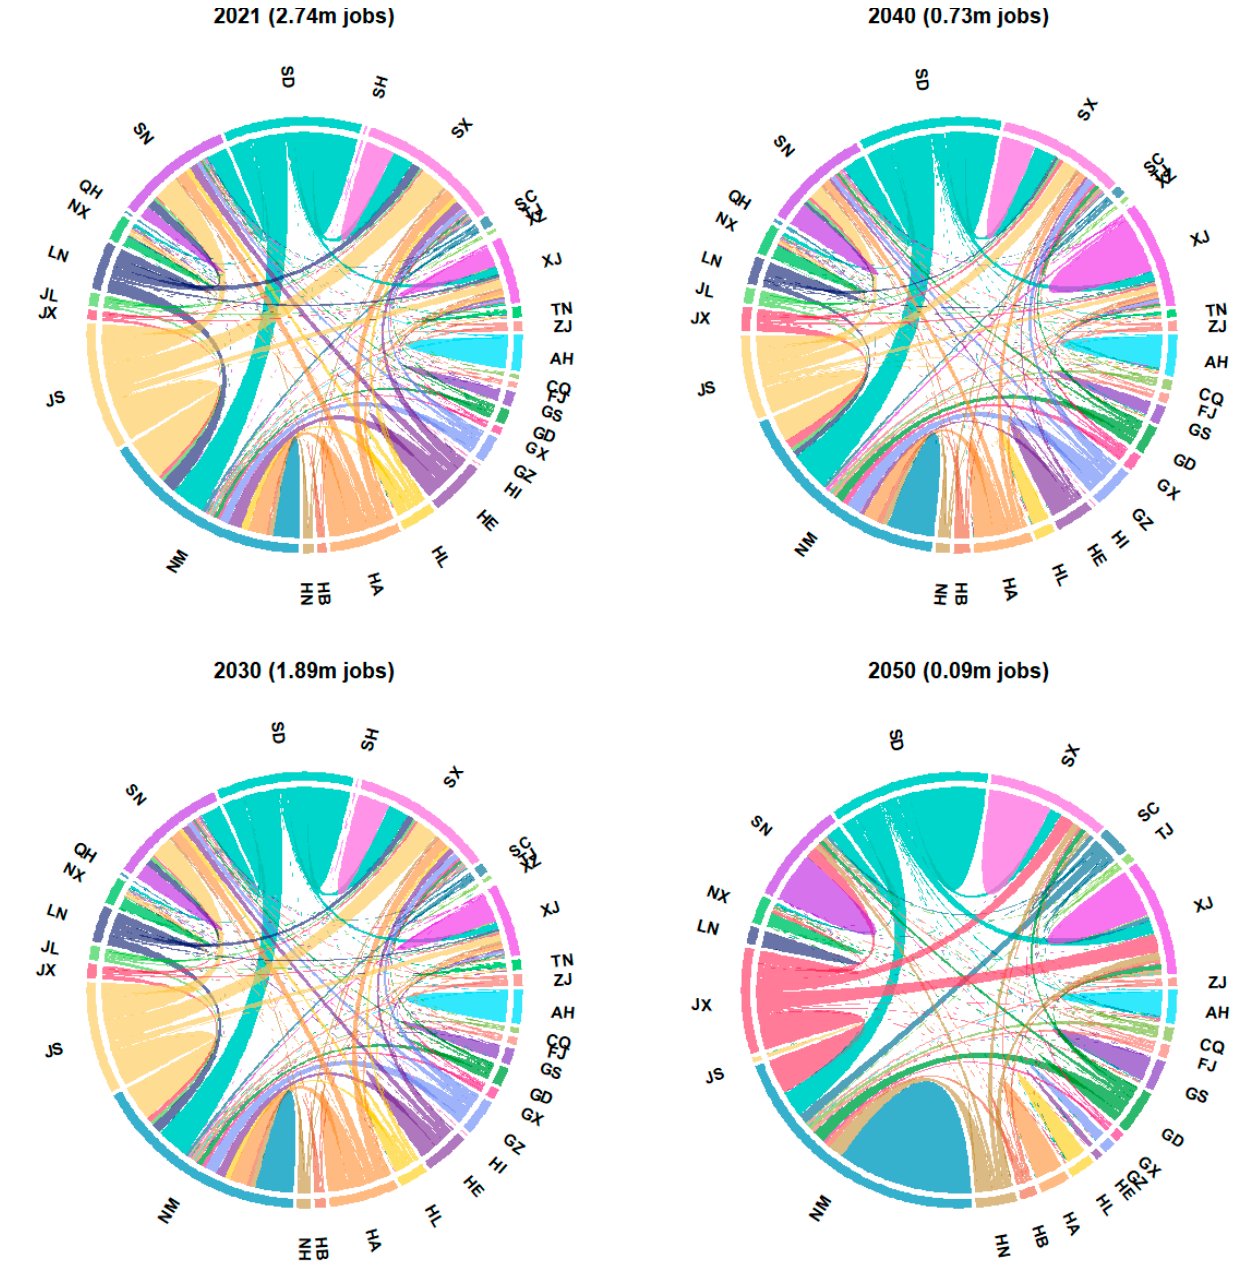
Figure 3. Coal jobs supported by each province, B scenario. Flows from province X (the colour of the outside ring) to province Y , in the same colour as province X , represent jobs in province Y supported by coal imports to fuel coal-fired power generation activity in province X . Table 2. Summary information on estimated coal industry employment in 2021 (B scenario), in descending order of total jobs supported by coal power generation in each